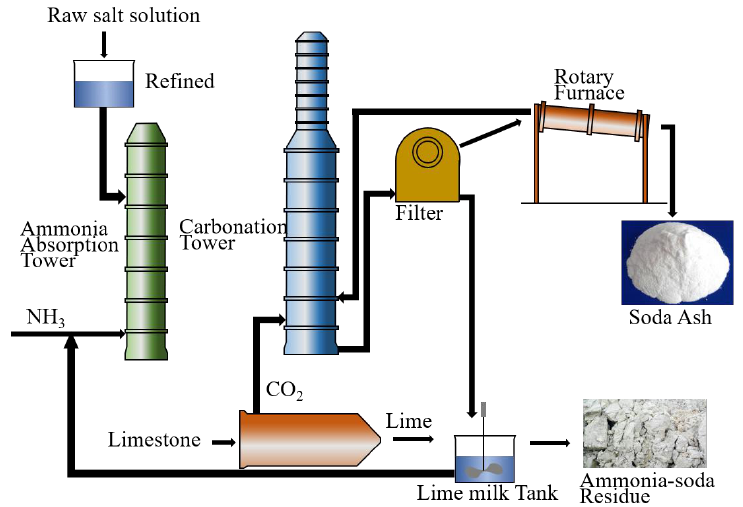
Figure 1. Generation process of ammonia soda ash and ammonia-soda residue.